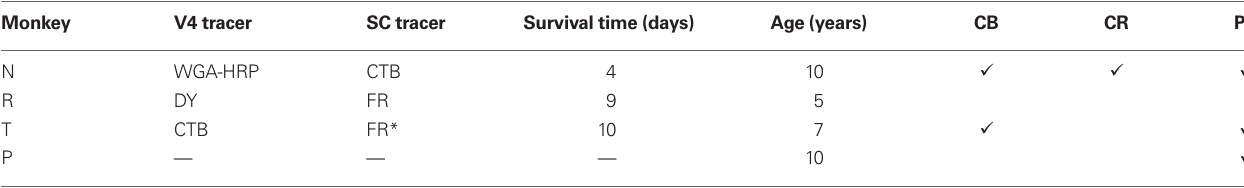
Table 1 | Summary of experiments, sorted by animal.